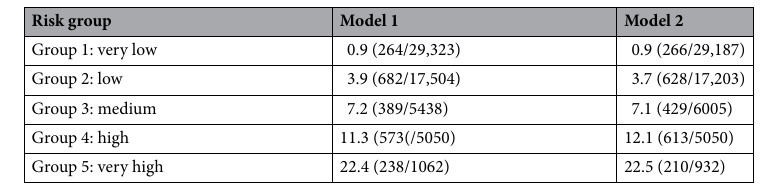
Table 3. Incidence of diabetes according to risk group classification. Data represented as % of positive cases (number of positive cases/total number of cases) Model 1 comprises age group, BMI group, SAF group; model 2 comprises age group, BMI group, SAF group and number of parents with